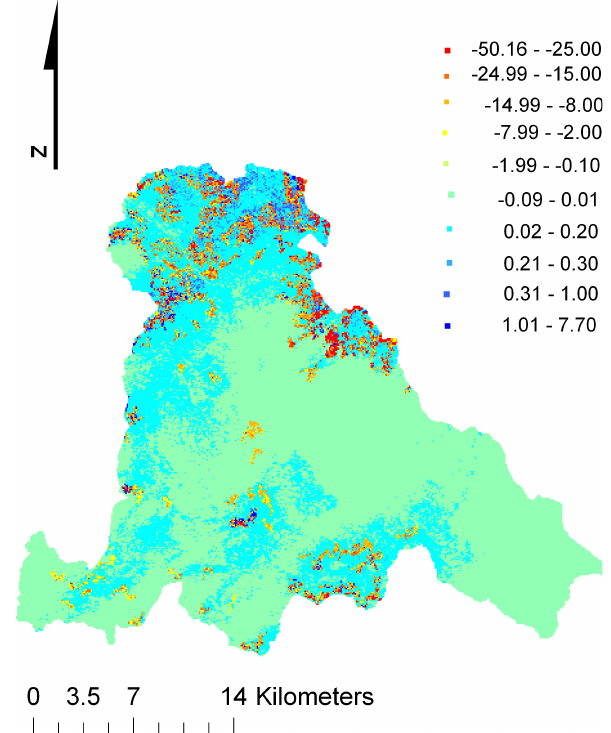
Fig. 5. Expected carbon difference (tonnesha − 1 ) between the non- treatment and treatment scenarios for the study